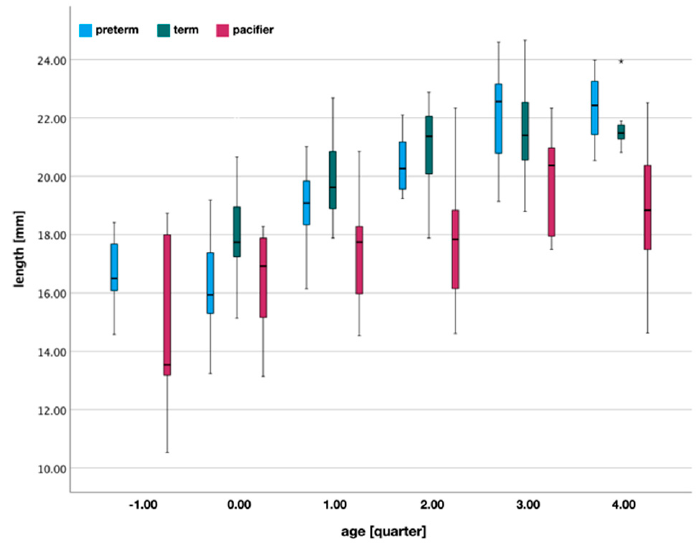
Figure 8. Pacifier (intraoral) length, in relation to the anteroposterior distance to the deepest point of the palatal vault. The infant palate values correspond to the position of the maternal nipple during NNS. The lengths of pacifiers are, significantly, too short compared to the palates of term infants. This does not apply to the palates of preterm infants in quarter − 1 and 0. (*) extreme outlier.